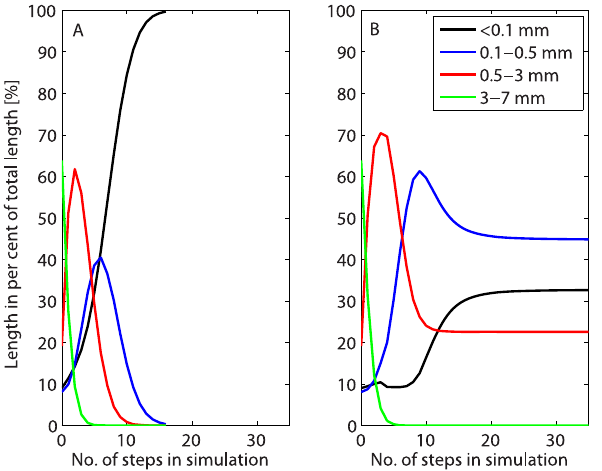
Figure 3. Two different simulated fibre length distributions for flax based on the actual fibre lengths prior to hydrolysis. A) random segmentation of fibres, B) segmentation according to the mechanical principles outlined in Figure 1 and equations (1) and (2). In the simulation in B), the parameter M u /P was set to 400 in step 1 and to decrease by 25% in each step until it reached